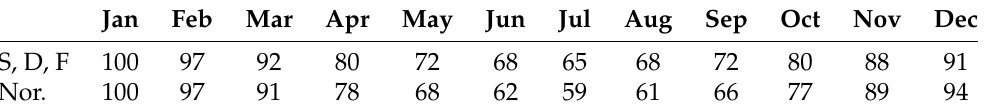
Table 2. The average consumption compared with the consumption in January in Sweden, Denmark, Finland (S, D, F), and Norway (Nor) in the period of 2013–2020. Consumption in January is equal to 100.